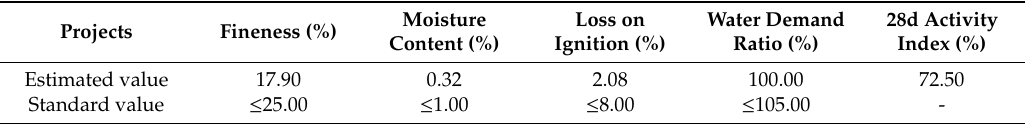
Table 4. Chemical composition of fly ash.